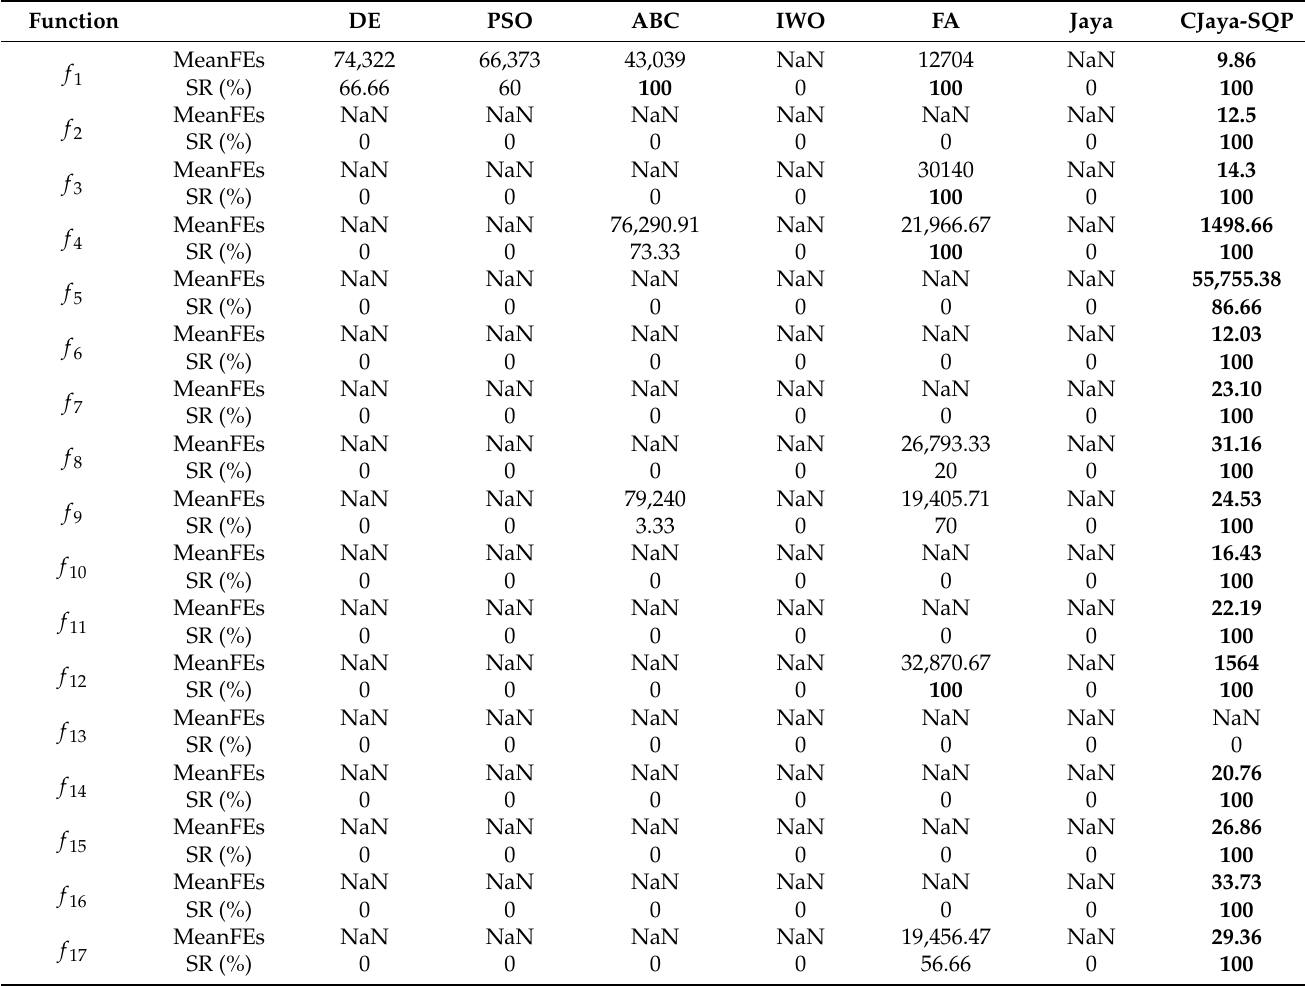
Table 9. Mean function evaluations required to reach the threshold value and success rate by various algorithms for 100-dimensional functions over 30